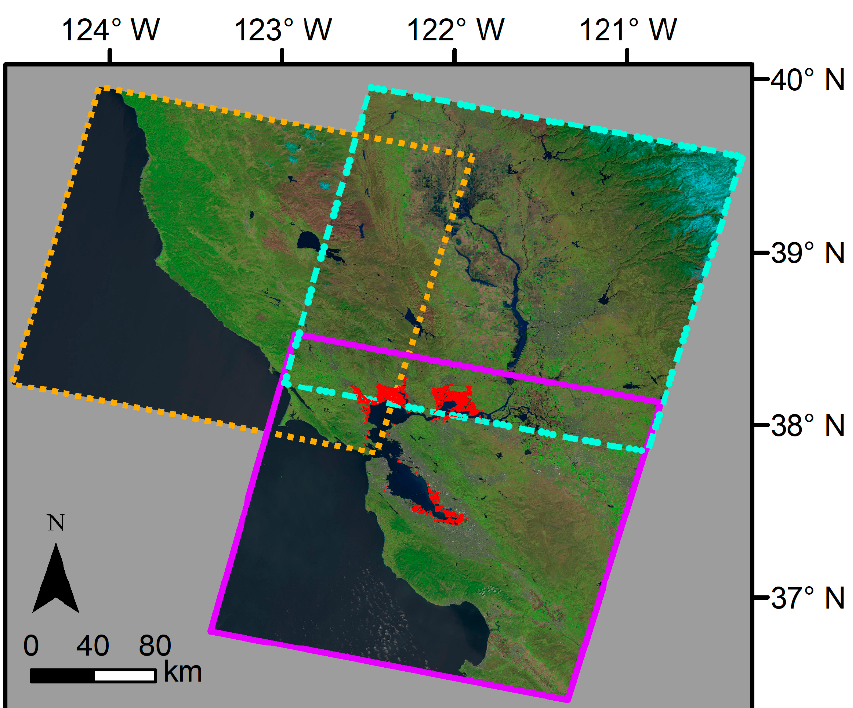
Figure A1. The three Landsat tiles that overlap our study area. Bay Area wetlands are highlighted in red. The main Landsat tile, WRS-2 path 44, row 34, is outlined in purple, while additional Landsat tiles that cover parts of San Pablo Bay and Suisun Bay are outlined in blue (WRS-2 path 45, row 33) and orange (WRS-2 path 44, row 33). Basemap: Landsat 8, U.S. Geological Survey.